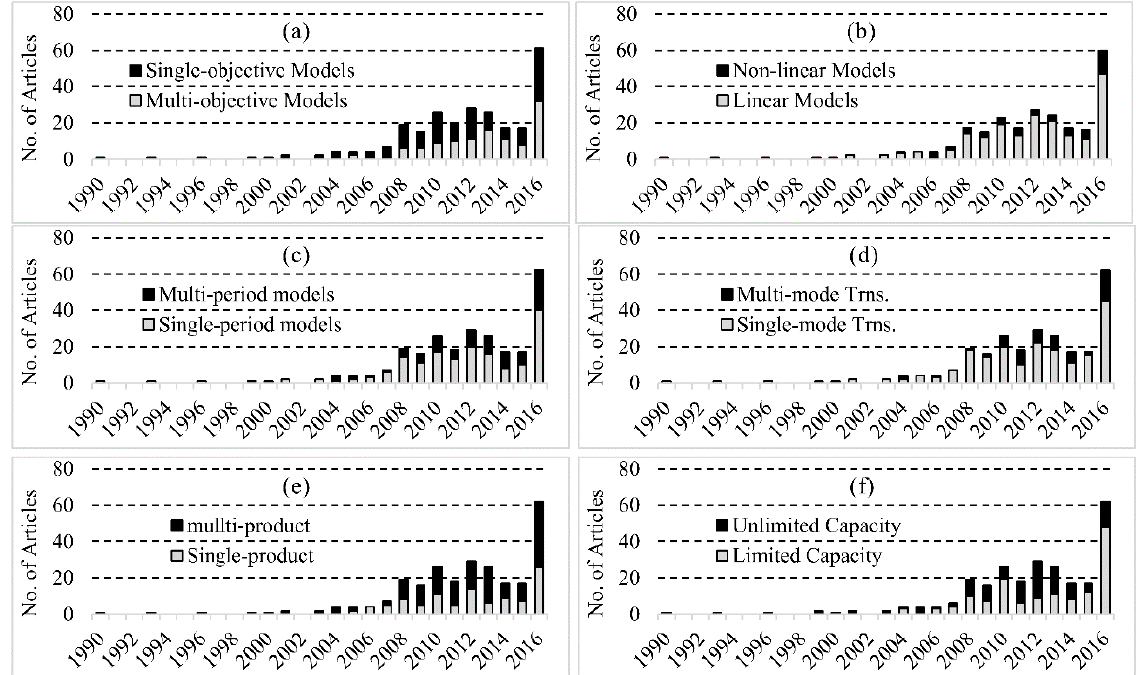
Figure 4. Frequencies of selected articles in each of sextet characteristics of model in desired horizon Supply Chain Network